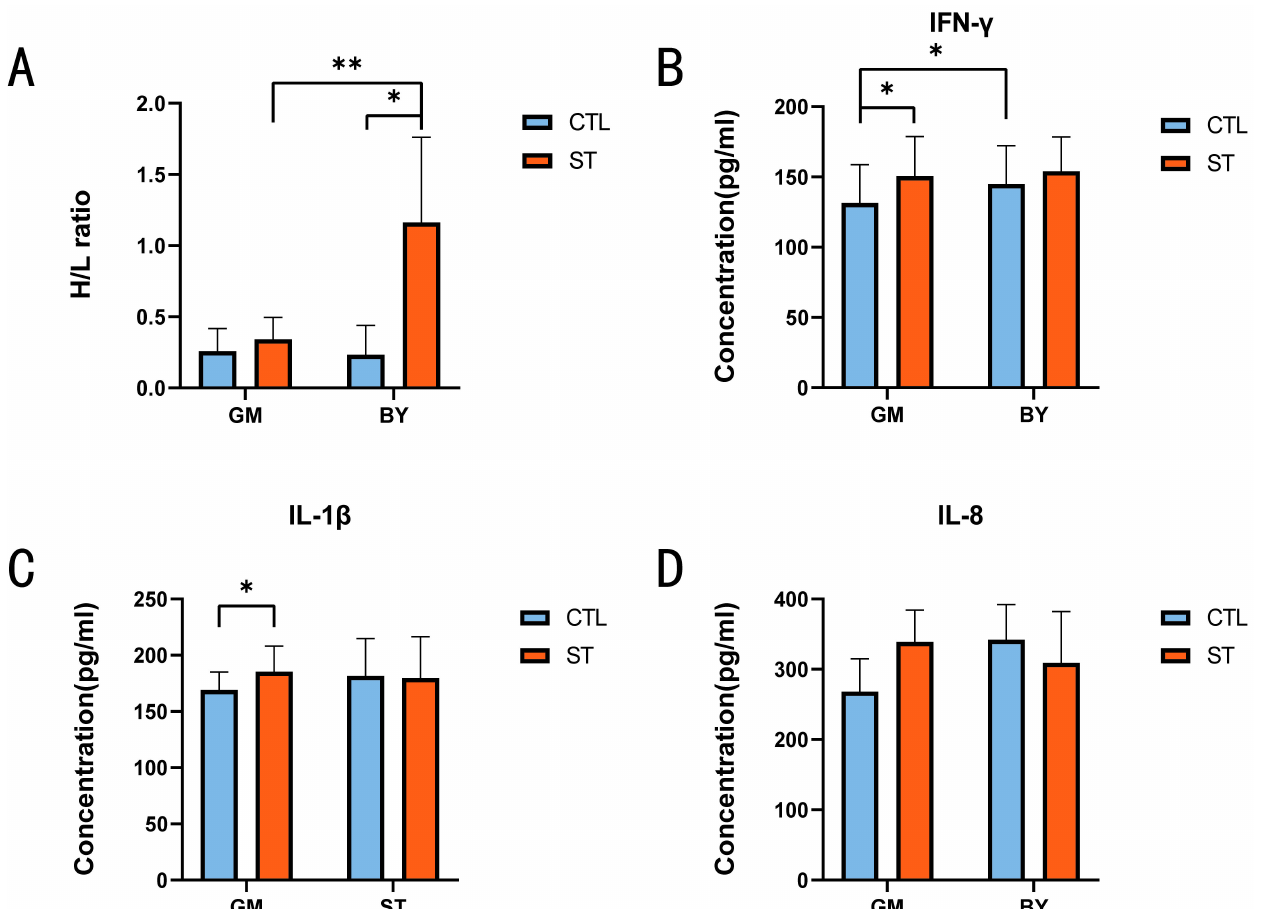
Figure 1. Comparison of phenotypic data between the ST and the control groups in BY and GM. ( A ) Comparison of H/L ratio of the ST and control groups in BY and GM. ( B ) Comparison of IFN- γ of the ST and control groups in BY and GM. ( C ) Comparison of IL-1 β of the ST and control groups in BY and GM. ( D ) Comparison of IL-8 of the ST and control groups in BY and GM. Eight